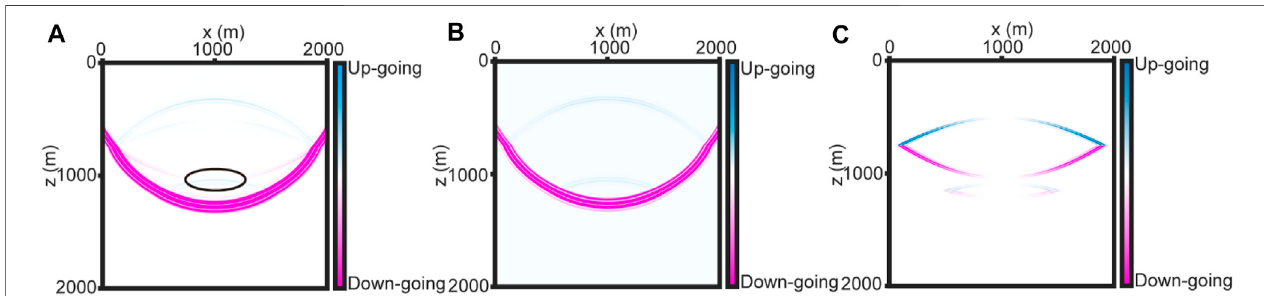
FIGURE 3 | Comparisons of Poynting vector snapshots for the velocity-stress equations and velocity-dilatation-rotation equations at 0.495 s. Blue represents the up-going wave and pink represents the down-going wave, respectively. (A) A snapshot of the z-component of the Poynting vector using the velocity-stress equations. The black ellipse indicates locations that P- and S-waves exist simultaneously. (B) A snapshot of the z-component of the Poynting vector of the P-wave using the velocity-dilatation-rotation equations. (C) A snapshot of the z-component of the Poynting vector of the S-wave using the velocity-dilatation-rotation equations.